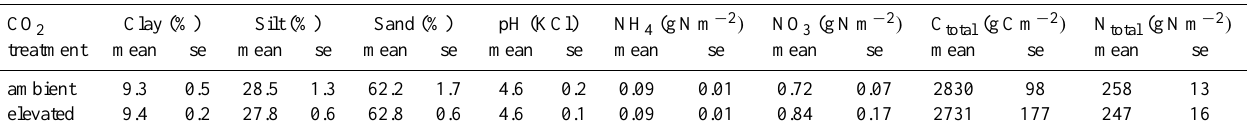
Table 2. Initial soil conditions at the BangorFACE experimental site.